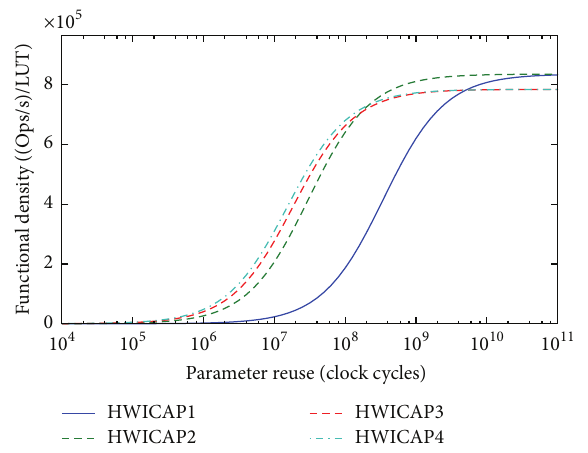
Figure 9: Functional density curves for HWICAP with different reconfiguration drivers.